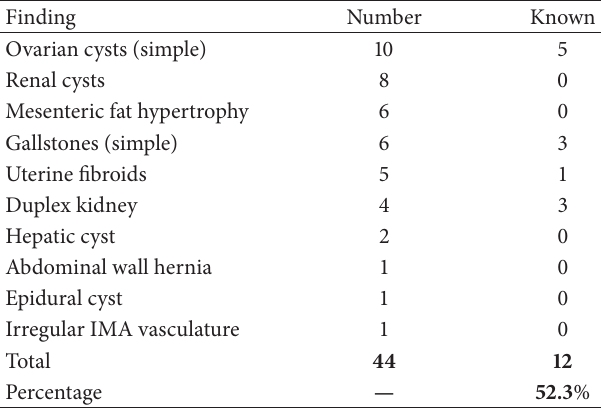
Table 3: Insignificant extraenteric